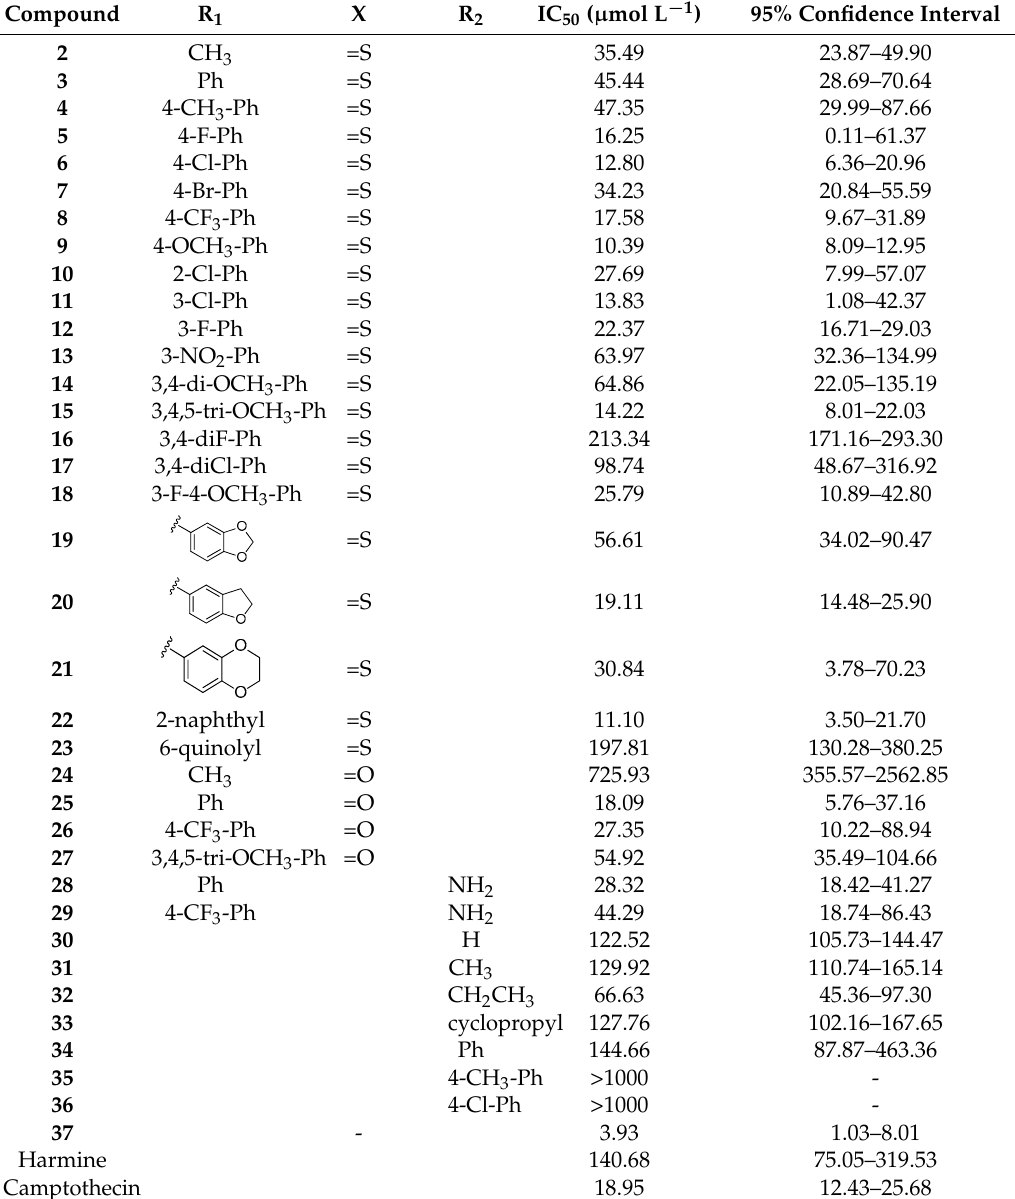
Table 1. In vitro cytotoxicity of compound 2–37 against sf9 cell.